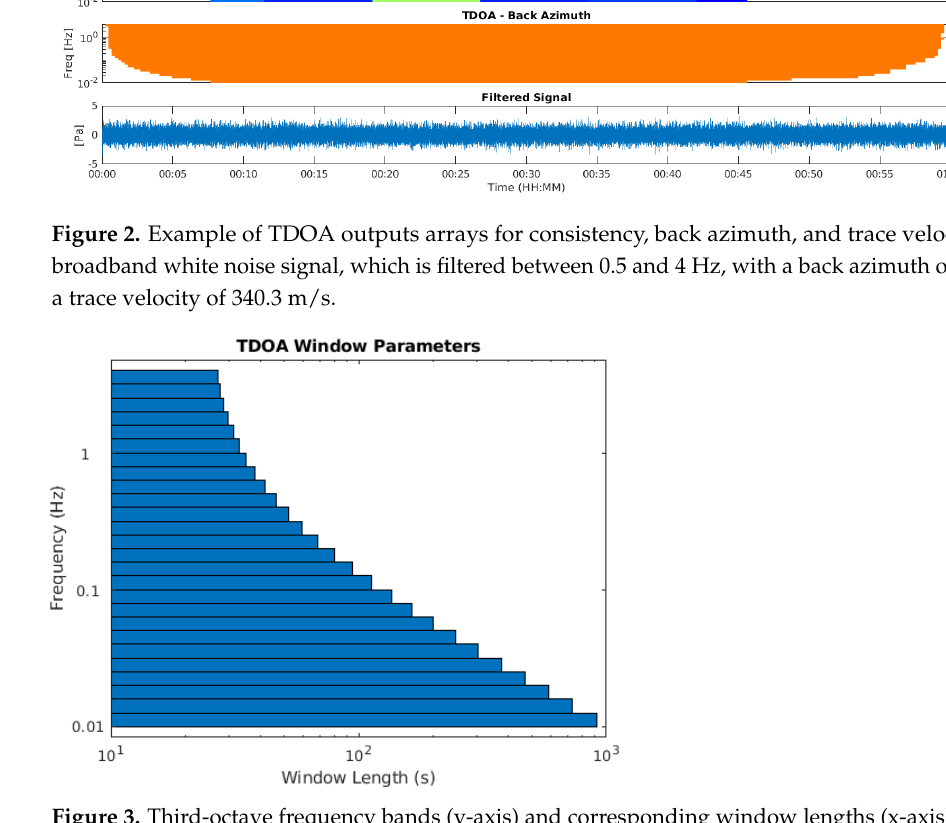
Figure 3. Third-octave frequency bands (y-axis) and corresponding window lengths (x-axis) used by TDOA for this